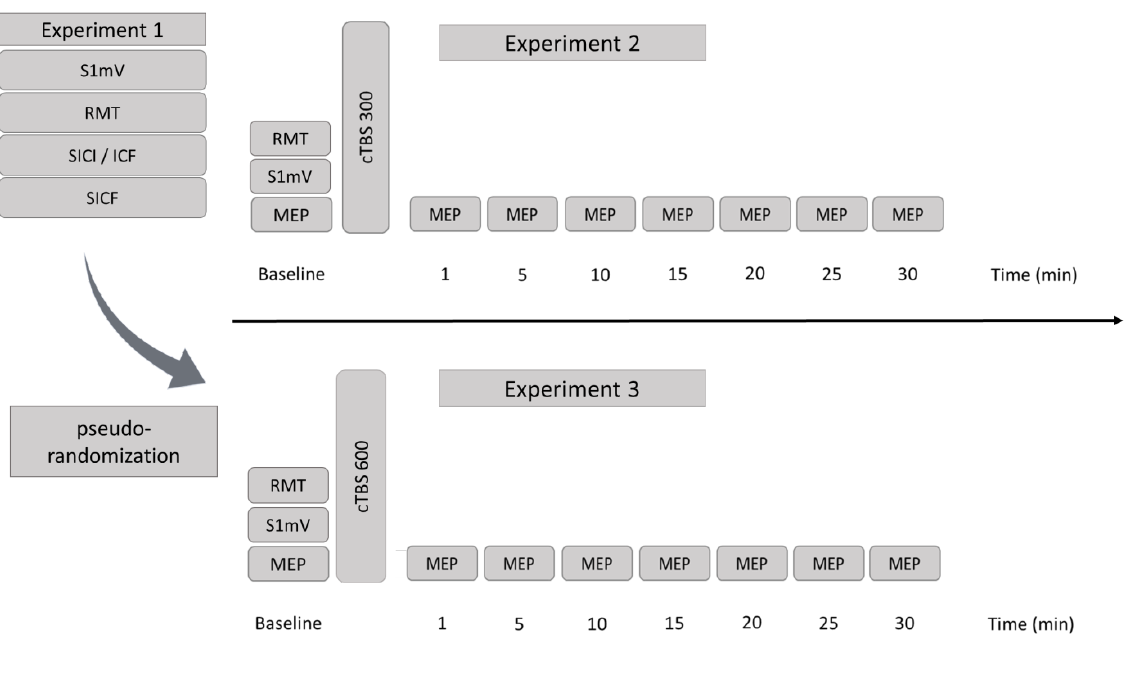
Table 1. Baseline motor-evoked potentials (MEP, monophasic), resting motor thresholds (RMT, monophasic in Experi- ment 1 and biphasic in Experiments 2 and 3), and intensities to evoke MEP of approximately 1 mV (S1 mV, monophasic in experiment 1 and biphasic in Experiments 2 and 3). To ensure comparability between both cTBS experiments, we com- puted paired samples t -tests comparing the baseline neurophysiological measures of Experiments 2 and 3. The respective analyses obtained no significant differences. Note: S1 mV data of one participant were excluded due to incomplete data acquisition. Data are shown as mean values ± standard deviation. mV: millivolt; %: percentage of stimulator output.